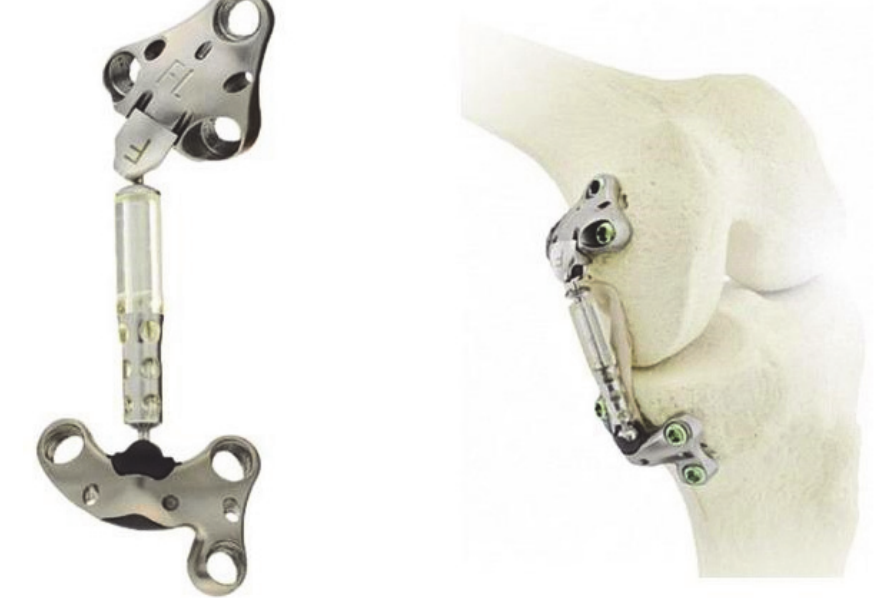
Figure 2: The assembled Atlas Knee System, designed to reduce loading on the affected medial compartment of the knee joint, consists of a load absorber located between femoral and tibial